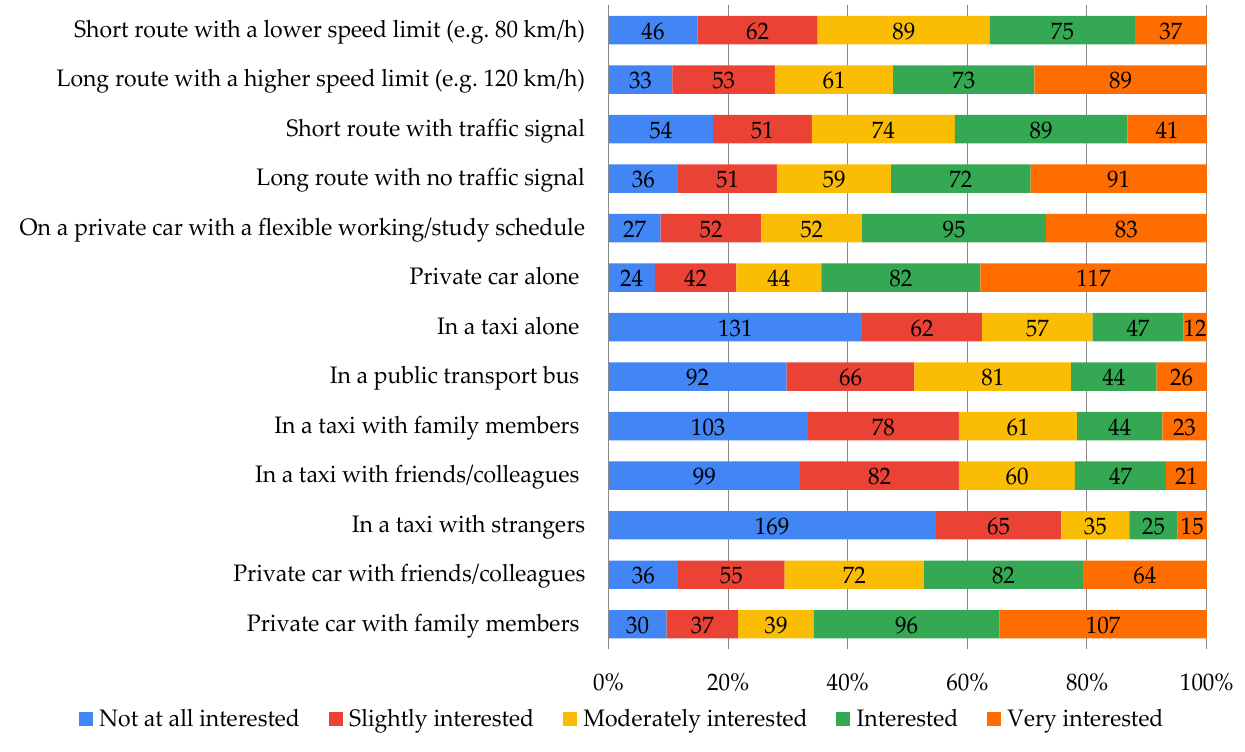
Figure 3. Distribution of responses level of interests in different scenarios for the travel time saving.